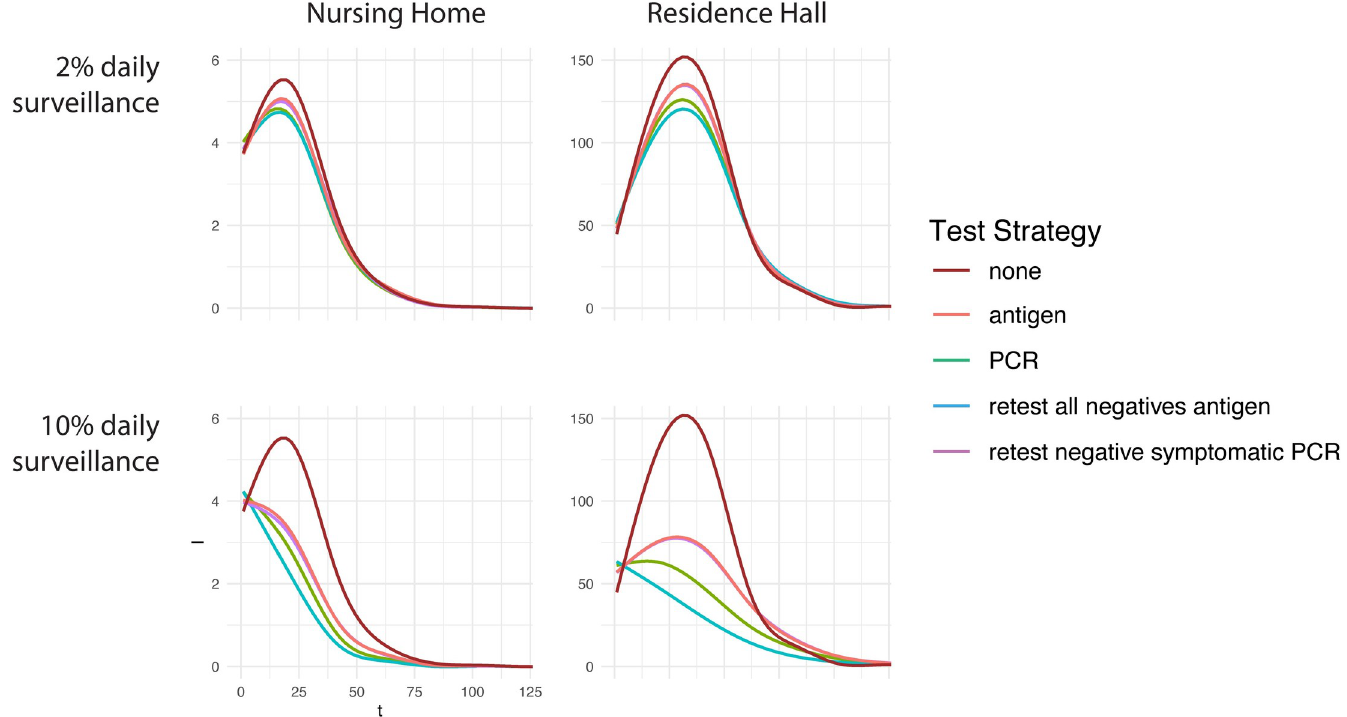
Fig 2. Epidemic curves showing infections over time in the nursing home (left) and residence hall (right) group living settings and at 2% and 10% daily surveillance testing. Higher levels of testing reduce infections. Different test strategies perform similarly. Line color indicates testing strategy. Curves for ‘antigen’ and ‘retest negative symptomatic PCR’ strategies are largely overlapping in every panel.